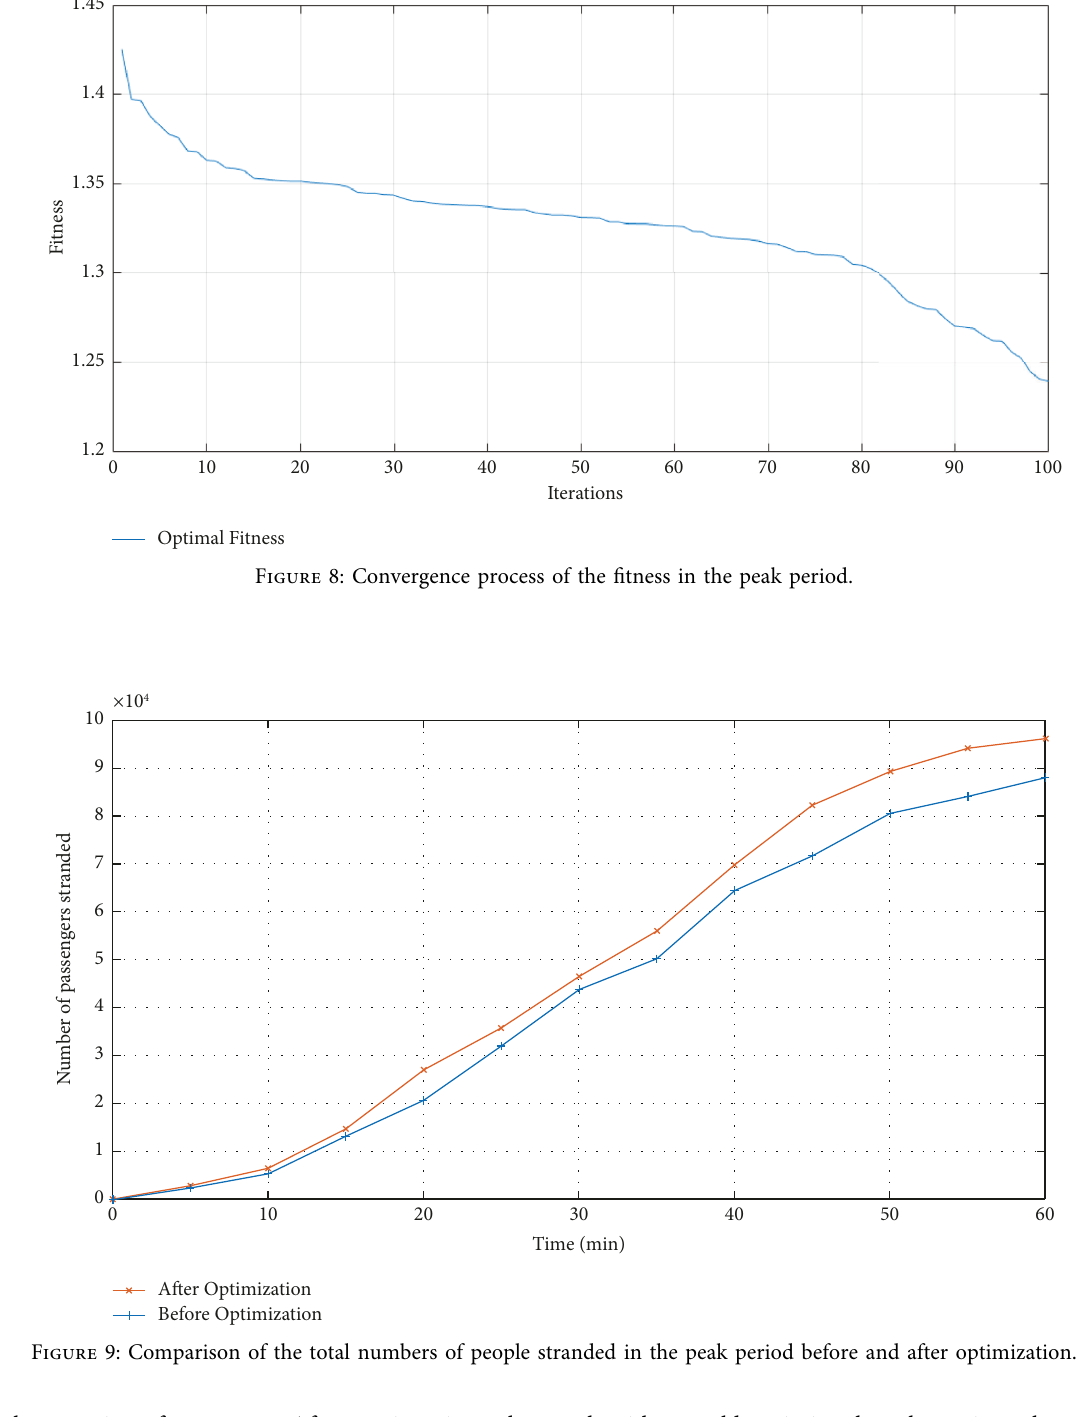
Figure 8. In solving this double-layer algorithm, the entire iterative process of 100 iterations took approximately 2 h because the calculation process involved many passengers.